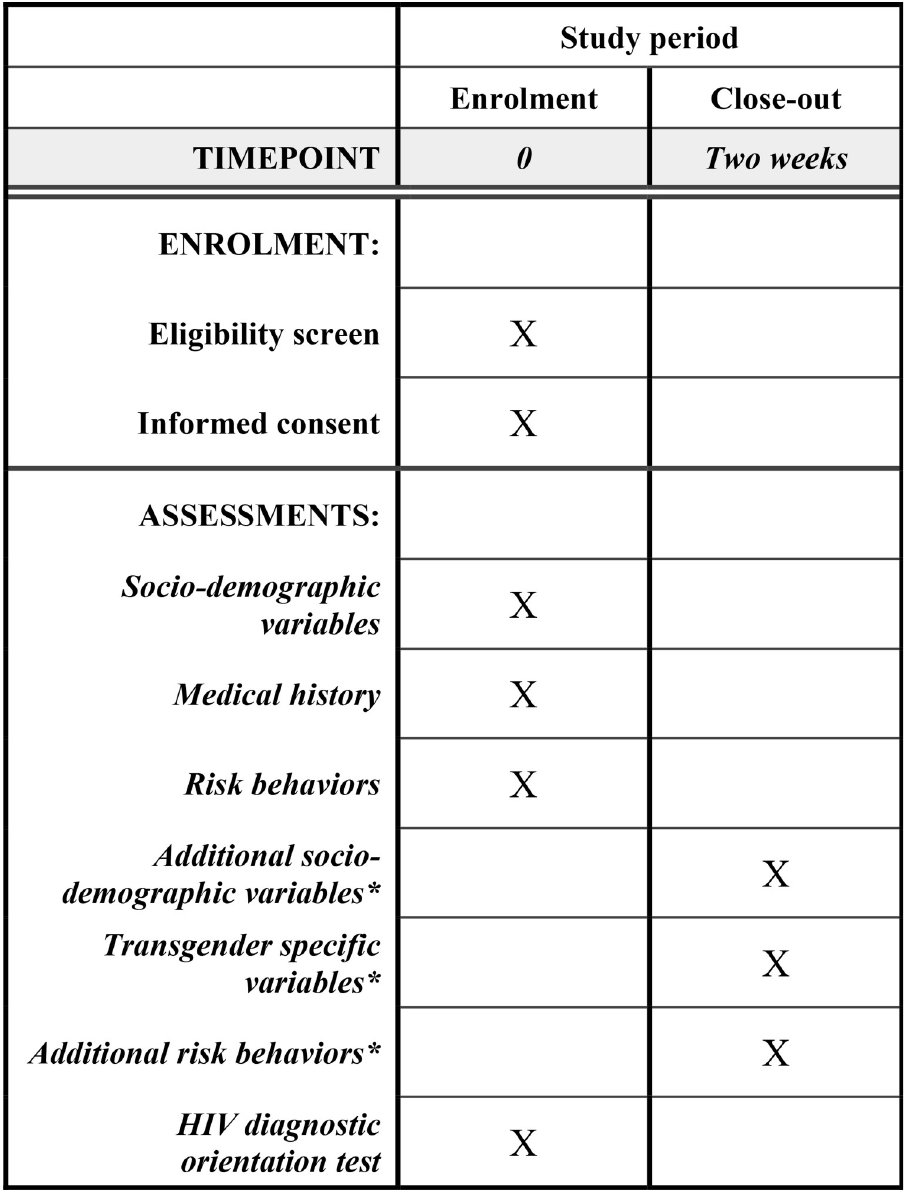
Fig 1. Schedule of enrolment and assessments. � Because of recruitment taking place in a variety of non-research settings, a relatively short questionnaire needs to be completed at enrolment, and a follow-up questionnaire with additional questions will be sent to the participants by email (cfr. PART